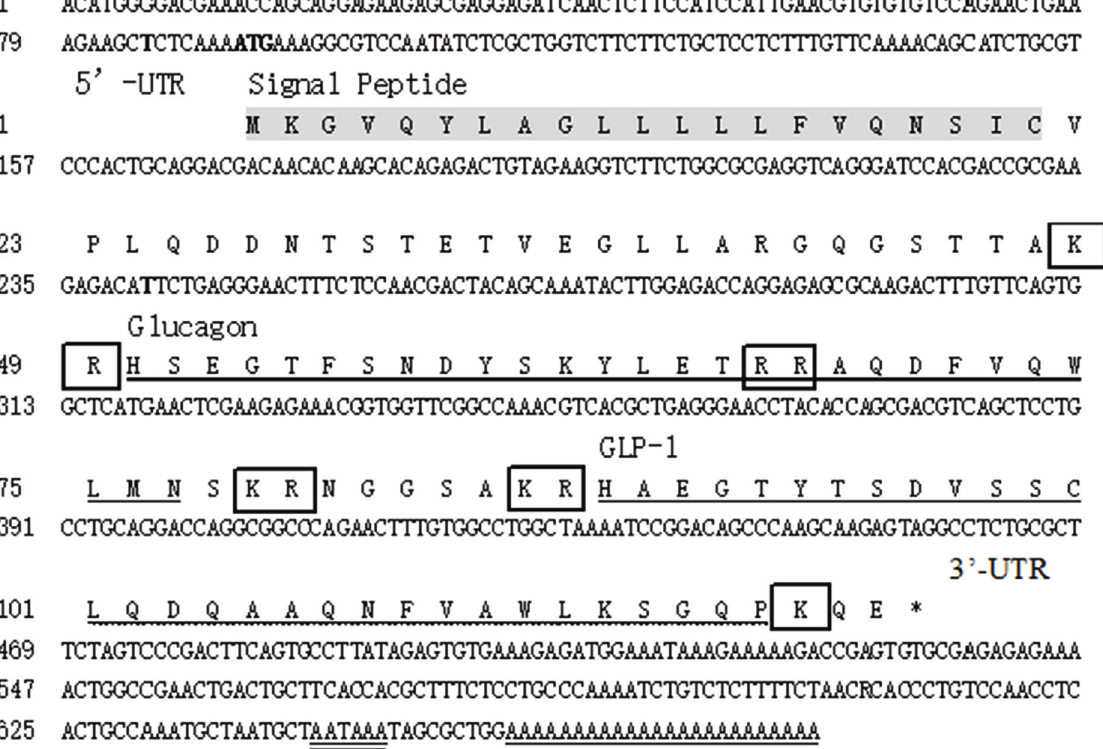
Figure 1: The pg complete cDNA sequences and predicted amino acids of S. denticulatus. The start codon is boldfaced. The stop codon is indicated by the “ ∗ ” . The gray highlighted characters in proper order indicate the signal peptide. Glucagon is underlined with “ ⎯ ” , and GLP-1 is underlined with “ ﹏ ” . Putative proteolytic cleavage sites are boxed, the add the tail signal of AATAAA is underlined with “ ═ ” , and the poly(A) is underlined with “ _ ”